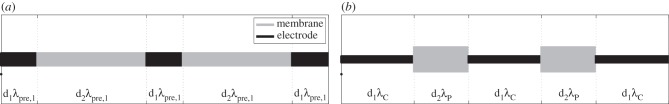
Cross-sectional view (not to scale) of a system using M = 3 active cells with the optimal parameters in table 3 in the (a) unactuated and (b) actuated configurations.